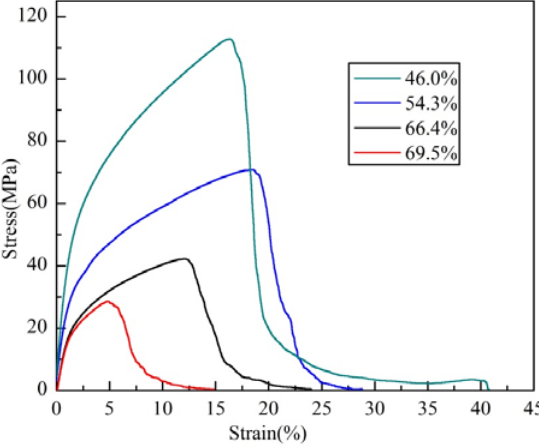
Figure 8. Uniaxial tensile stress-strain curves of the PTWMs with different